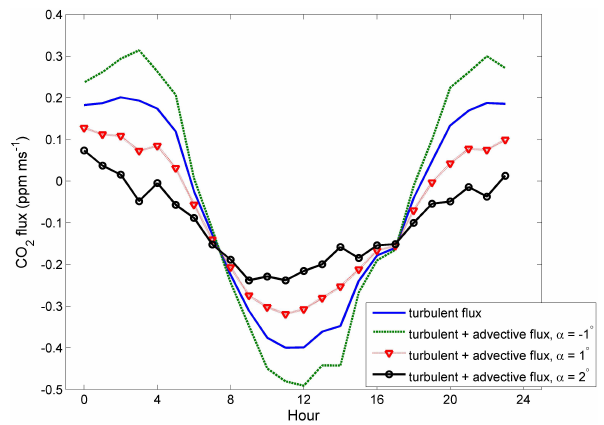
Fig. 7. Rough estimate of the vertical advection flux component in relation to the turbulent flux for tilt angles of − 1 ◦ , 1 ◦ and 2 ◦ at a mean wind speed of 4ms − 1 for carbon dioxide profile measurements from the [250 ◦ , 280 ◦ ] wind direction interval.